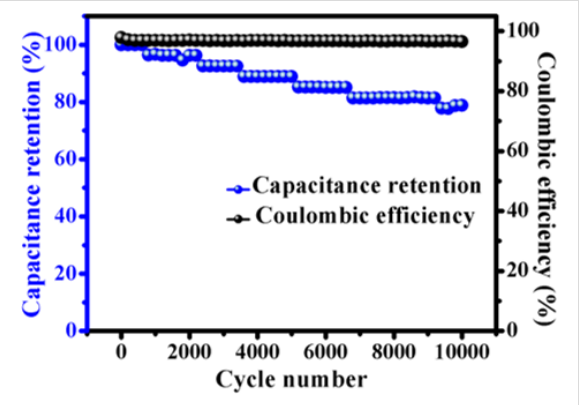
Figure 13: Capacitance retention and coulombic efficiency of the SSHSC at a current density of 5 A g − 1 .